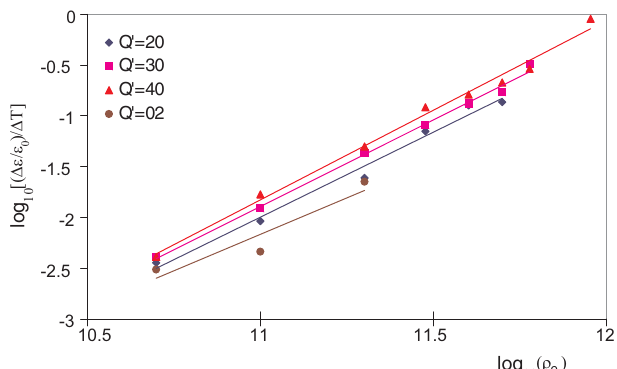
FIG. 14. (Color) Double logarithmic plot of the vertical emittance-growth rate as a function of the cloud density, for different